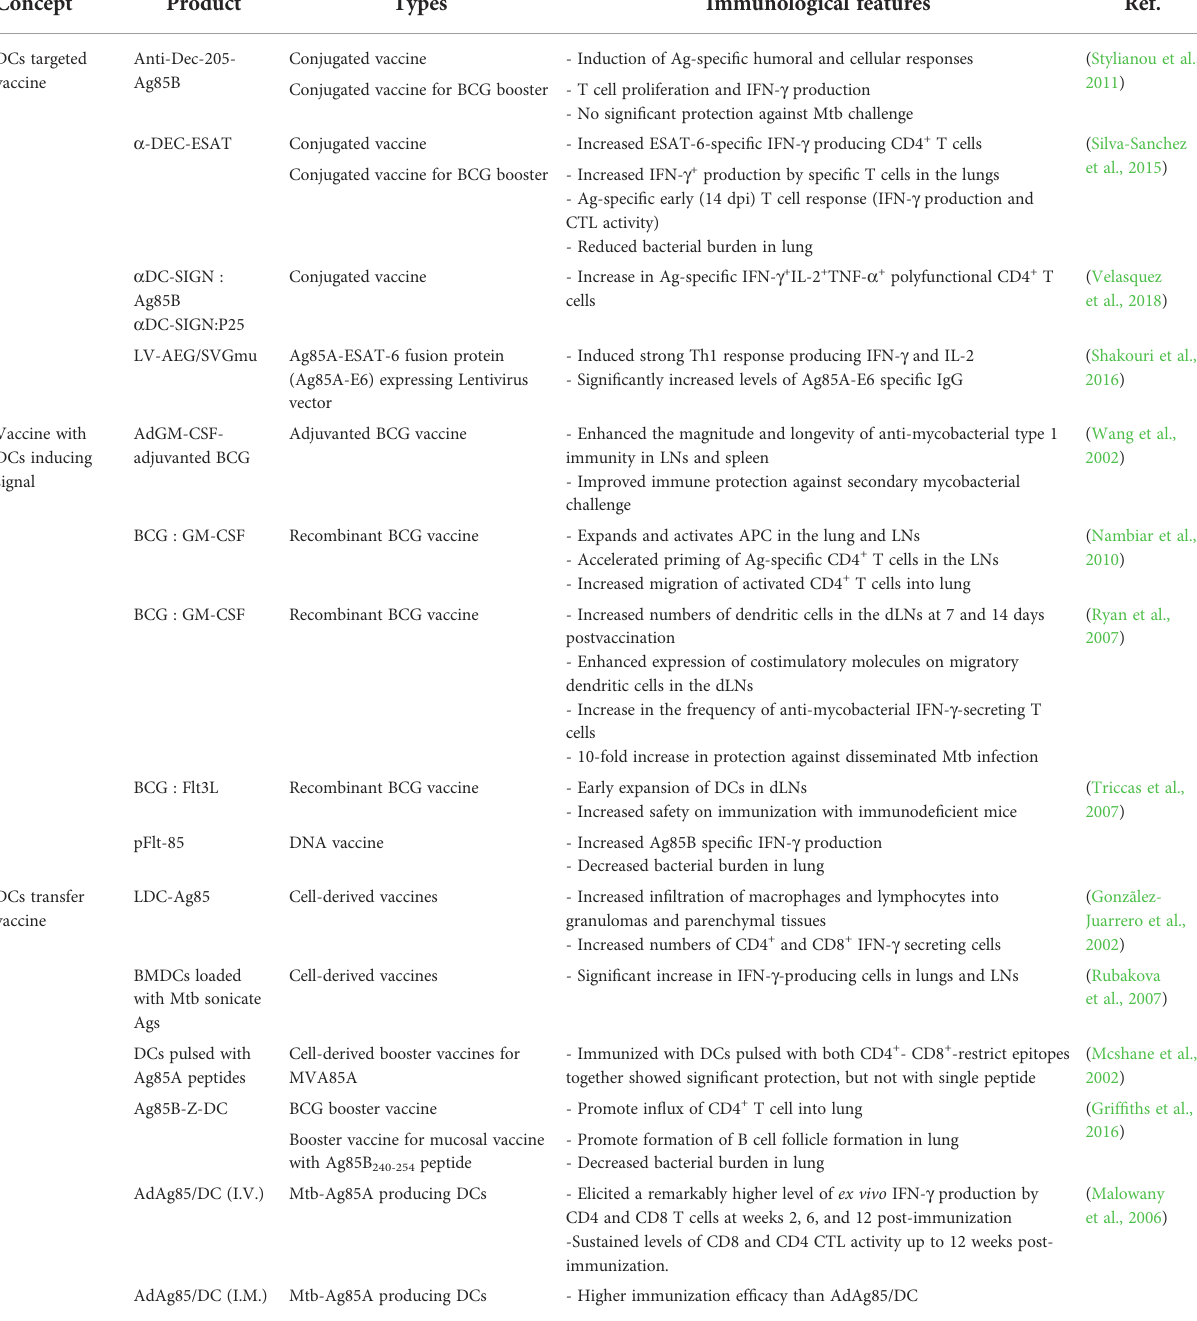
TABLE 3 Mechanisms of the targets of DC-based approaches in TB vaccine